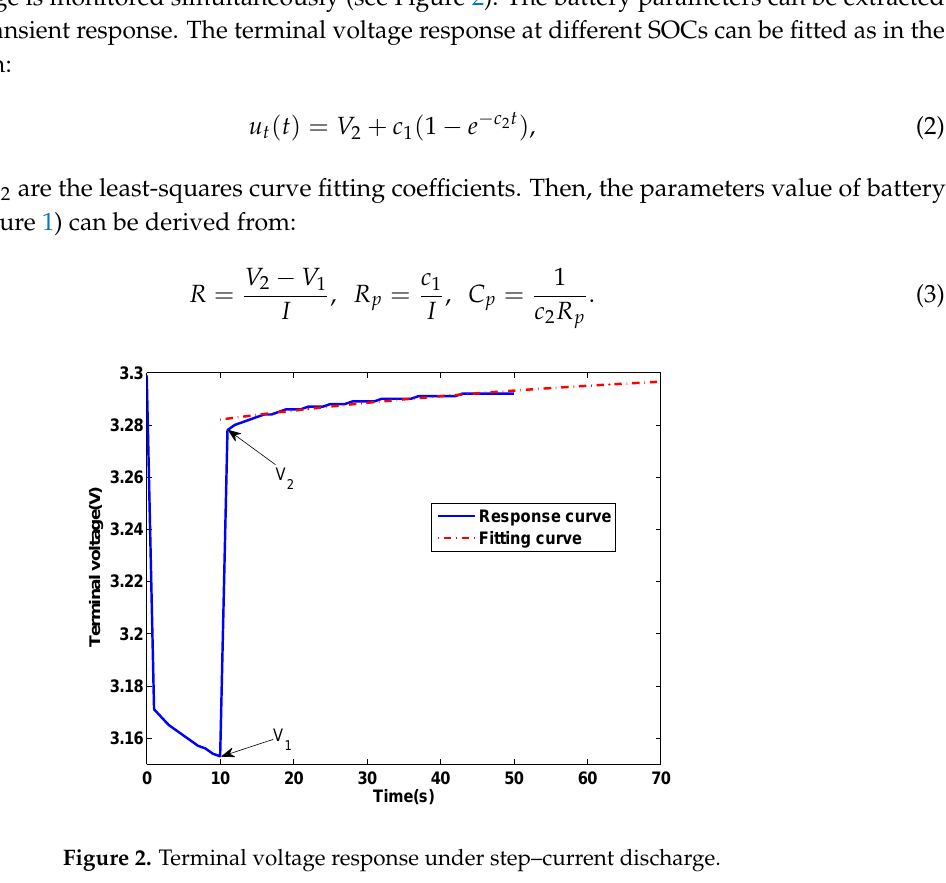
Figure 2. Terminal voltage response under step–current